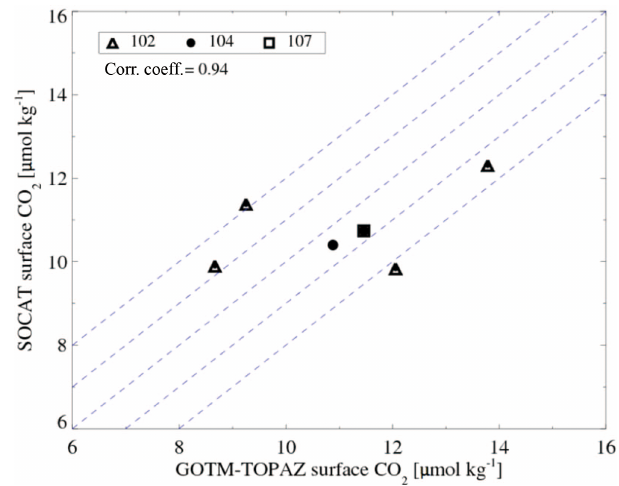
Figure 15. Scatter plot of mean monthly sea surface CO 2 concen- trations as observed by the Surface Ocean CO 2 Atlas and simulated by GOTM–TOPAZ. The thin dotted lines around the 1-to-1 line rep- resent ± 1 and 2µmolkg − 1 .